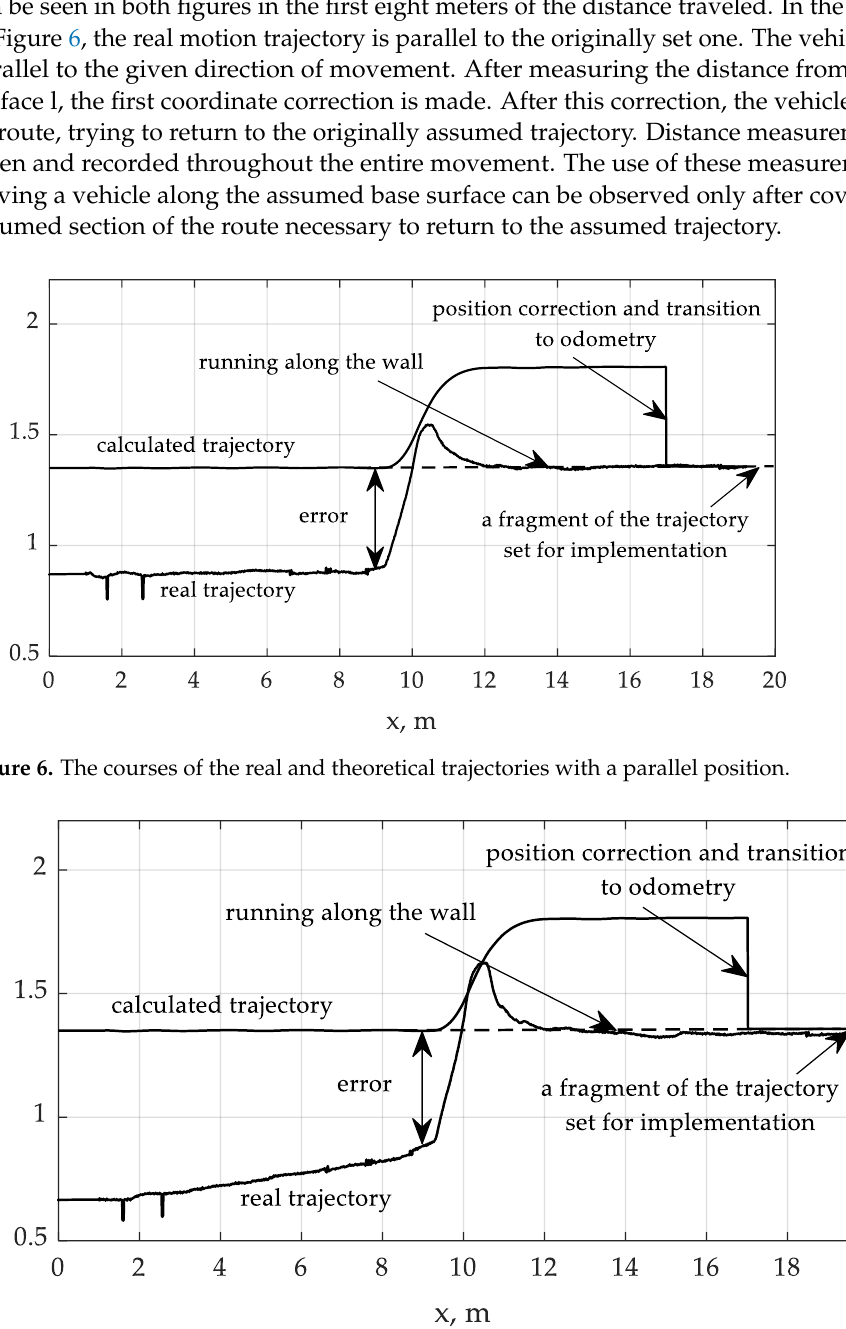
Figure 5. Parallel and non-parallel alignments of the AGV with respect to the reference surface.